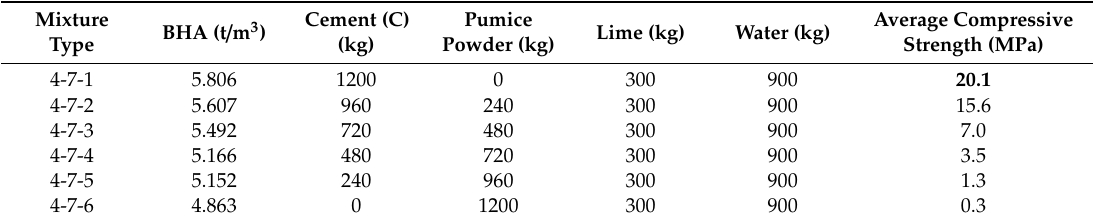
Table 31. Type-4-7 mixture quantity, weight per unit of volume and compression test results.